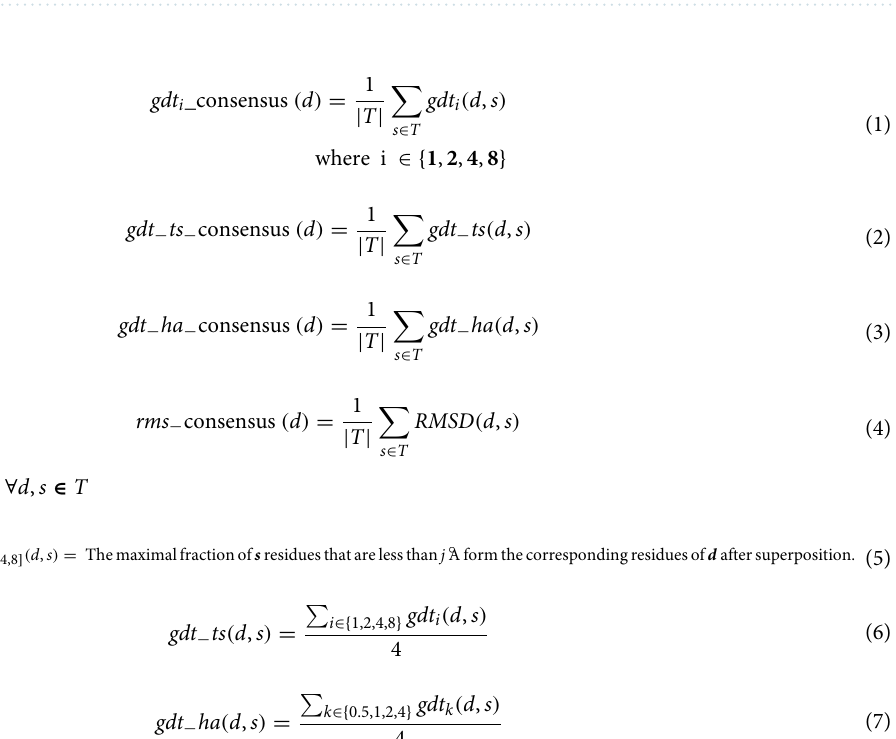
Figure 1. Target characteristics bias feature values. Each point in the figure represents the ”GOAP”S energy 60 and accuracy of a single structural model. Models of the two CASP targets T0601 and T0530 are depicted by blue and red points respectively. Accuracy is measured in GDT_TS between the models and the native structures, that is gdt − ts ( d , n ) , Eq. (6), where n is the native structure of that target). ”GOAP” energy term is a strong feature and it (anti) correlates well with the accuracies of both targets. Yet, given a feature value range (e.g., around–10,000), the qualities of the two proteins are very